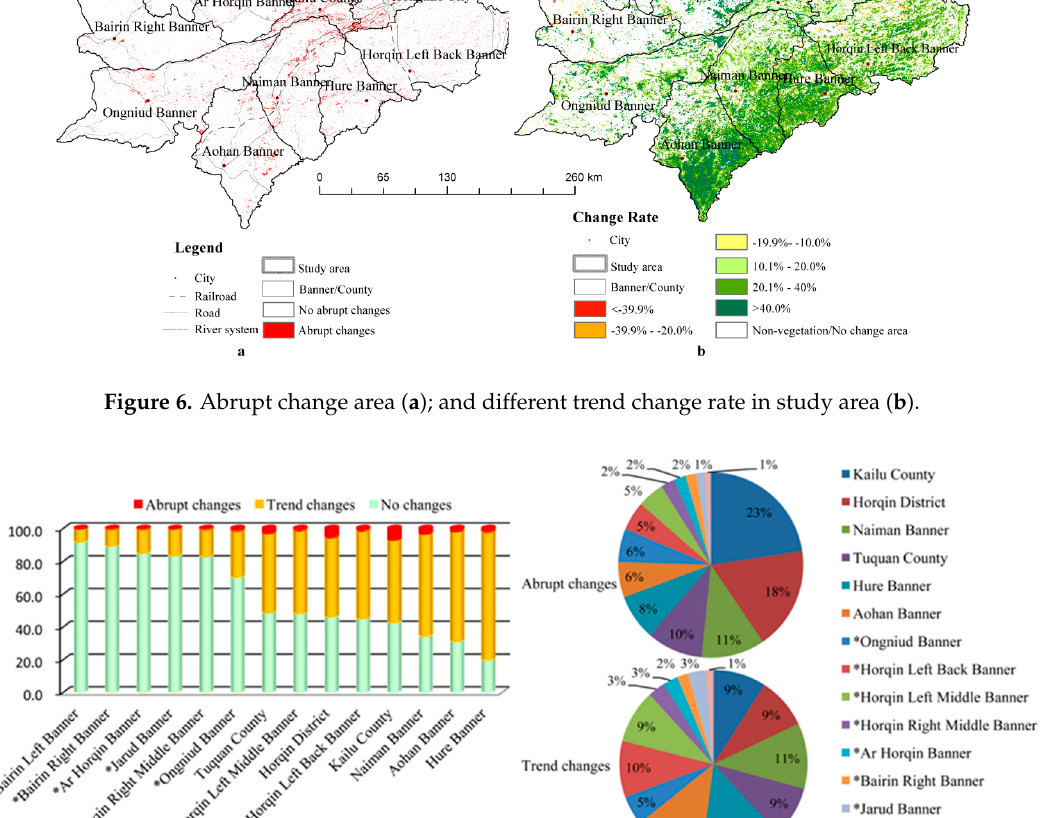
Figure 6. Abrupt change area ( a ); and different trend change rate in study area ( b ).